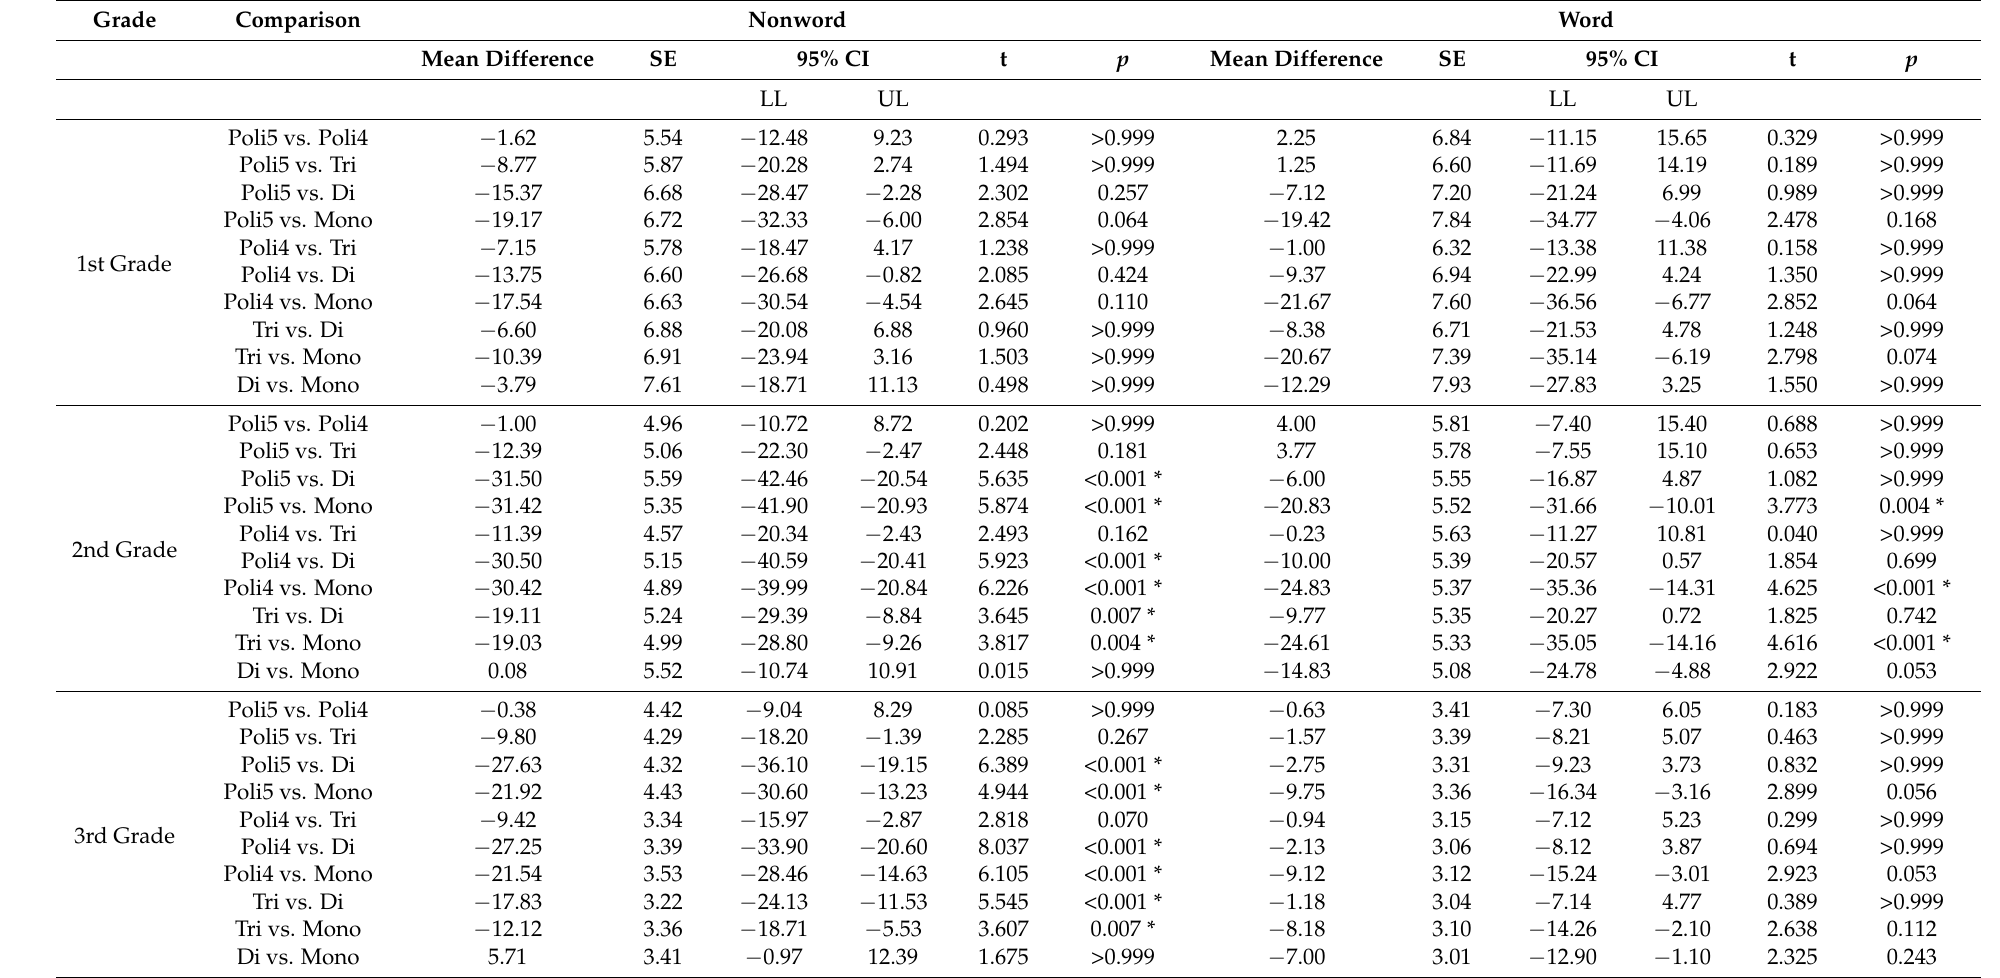
Table 5. Post hoc analyses of stimuli length according to type of stimuli and